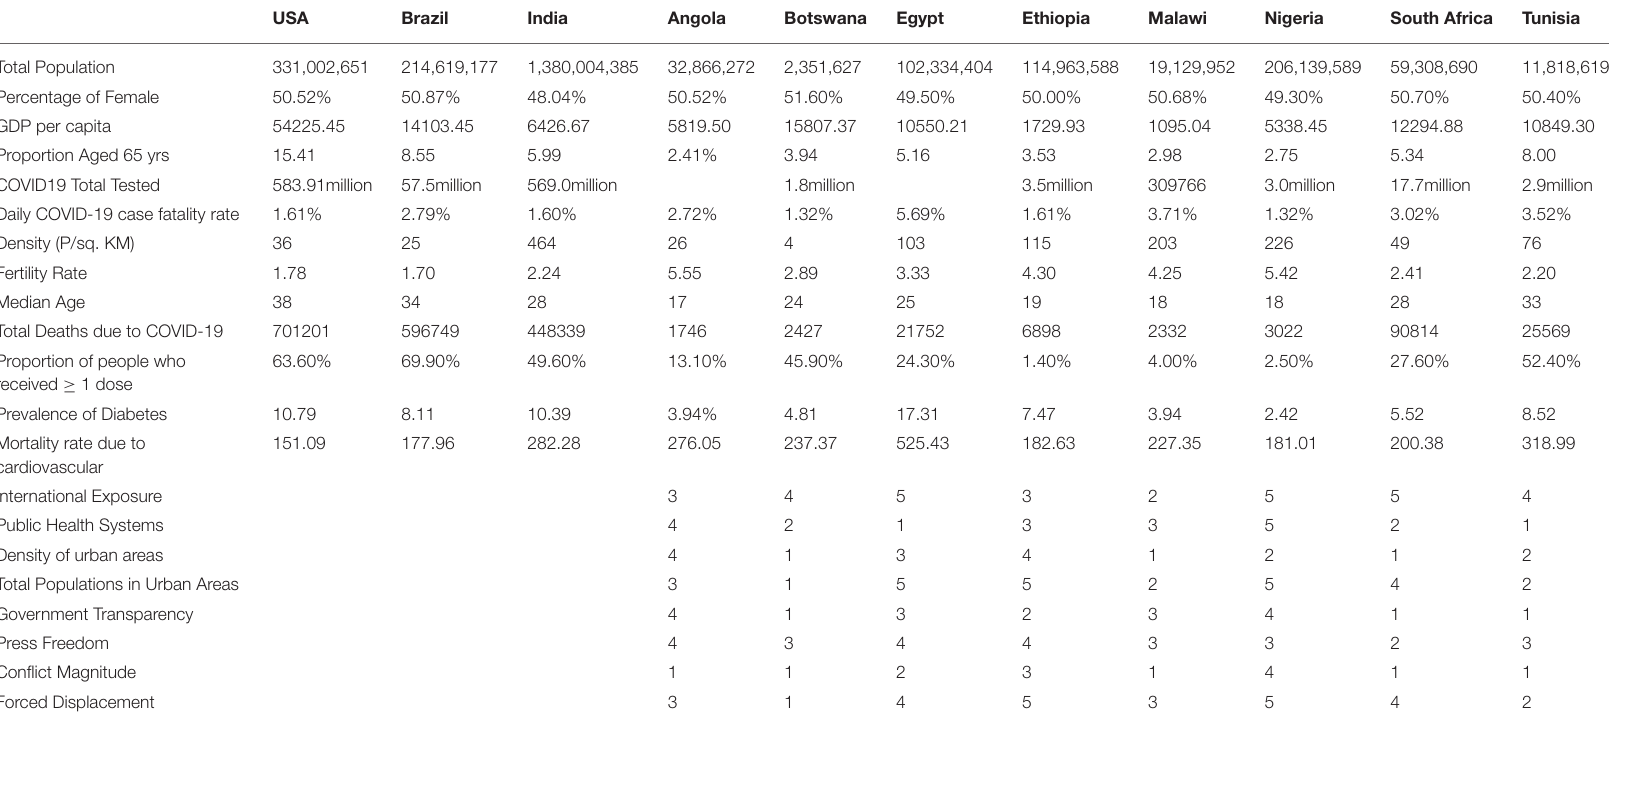
TABLE 1 | Summary of the country